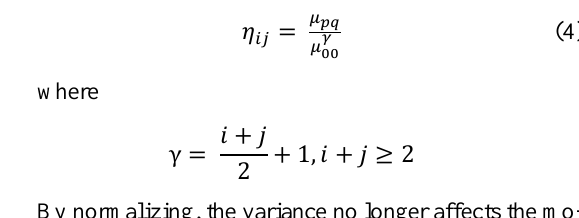
Figure 5: IR markers with the naked eye (left) and through the filter